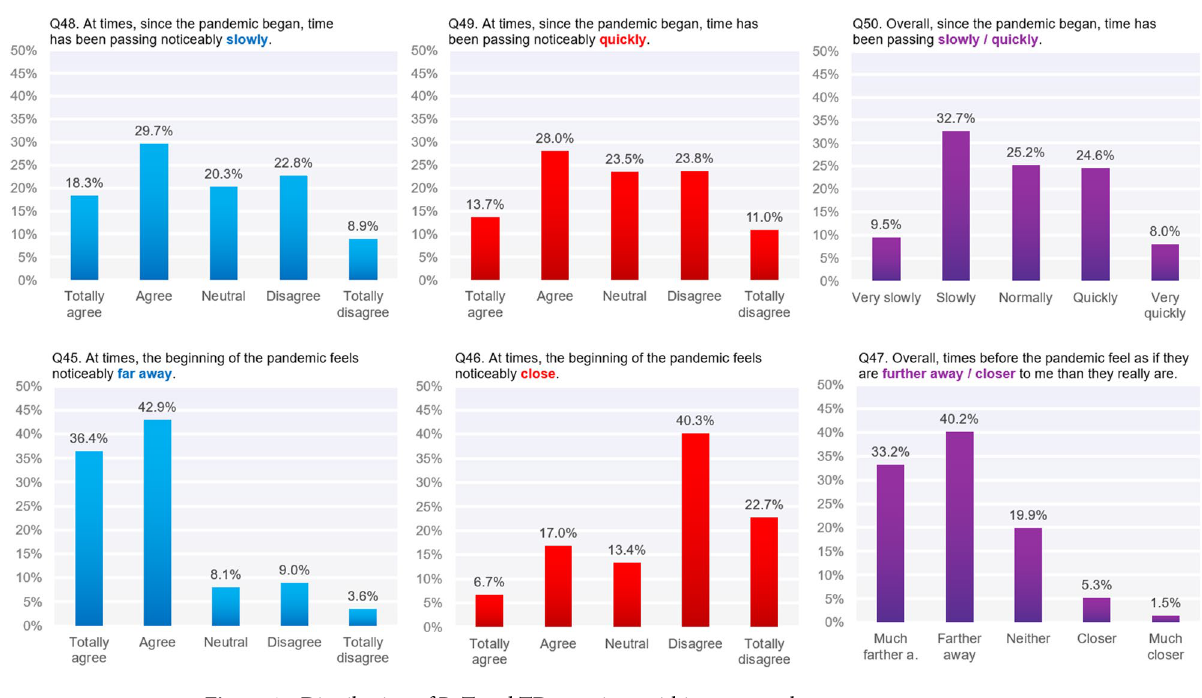
Figure 1. Distribution of PoT and TD questions within our